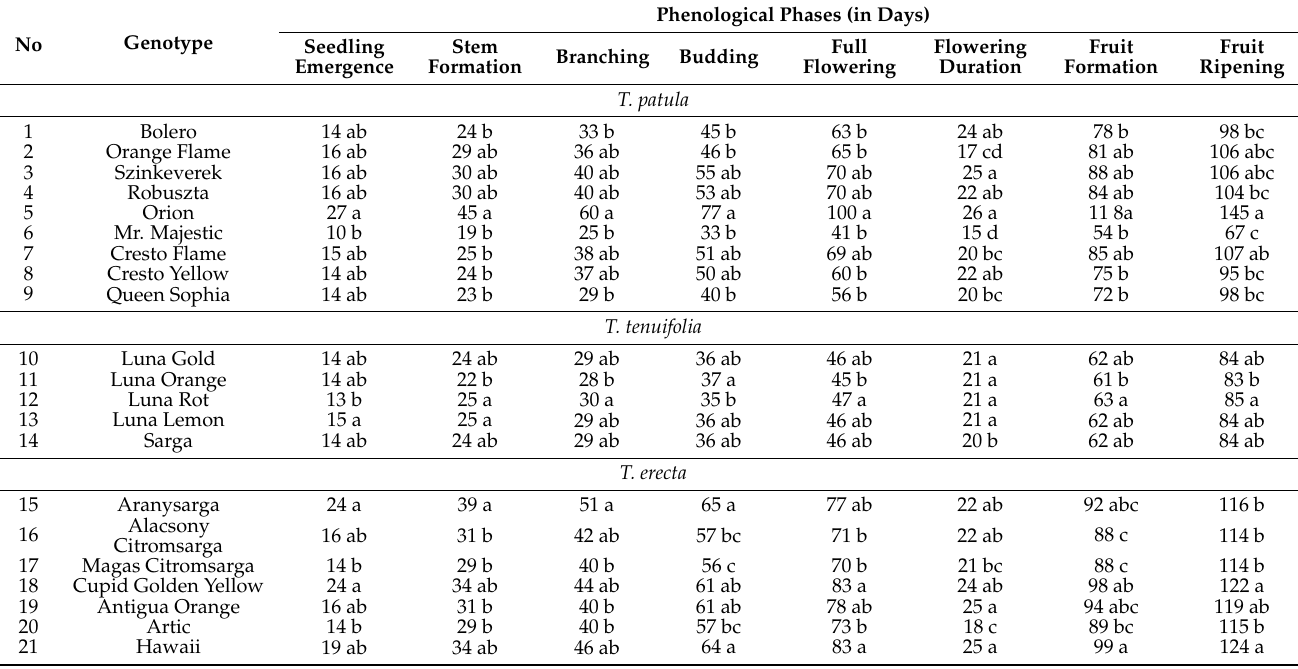
Table 4. Time (d) since sowing to reach the main phenological